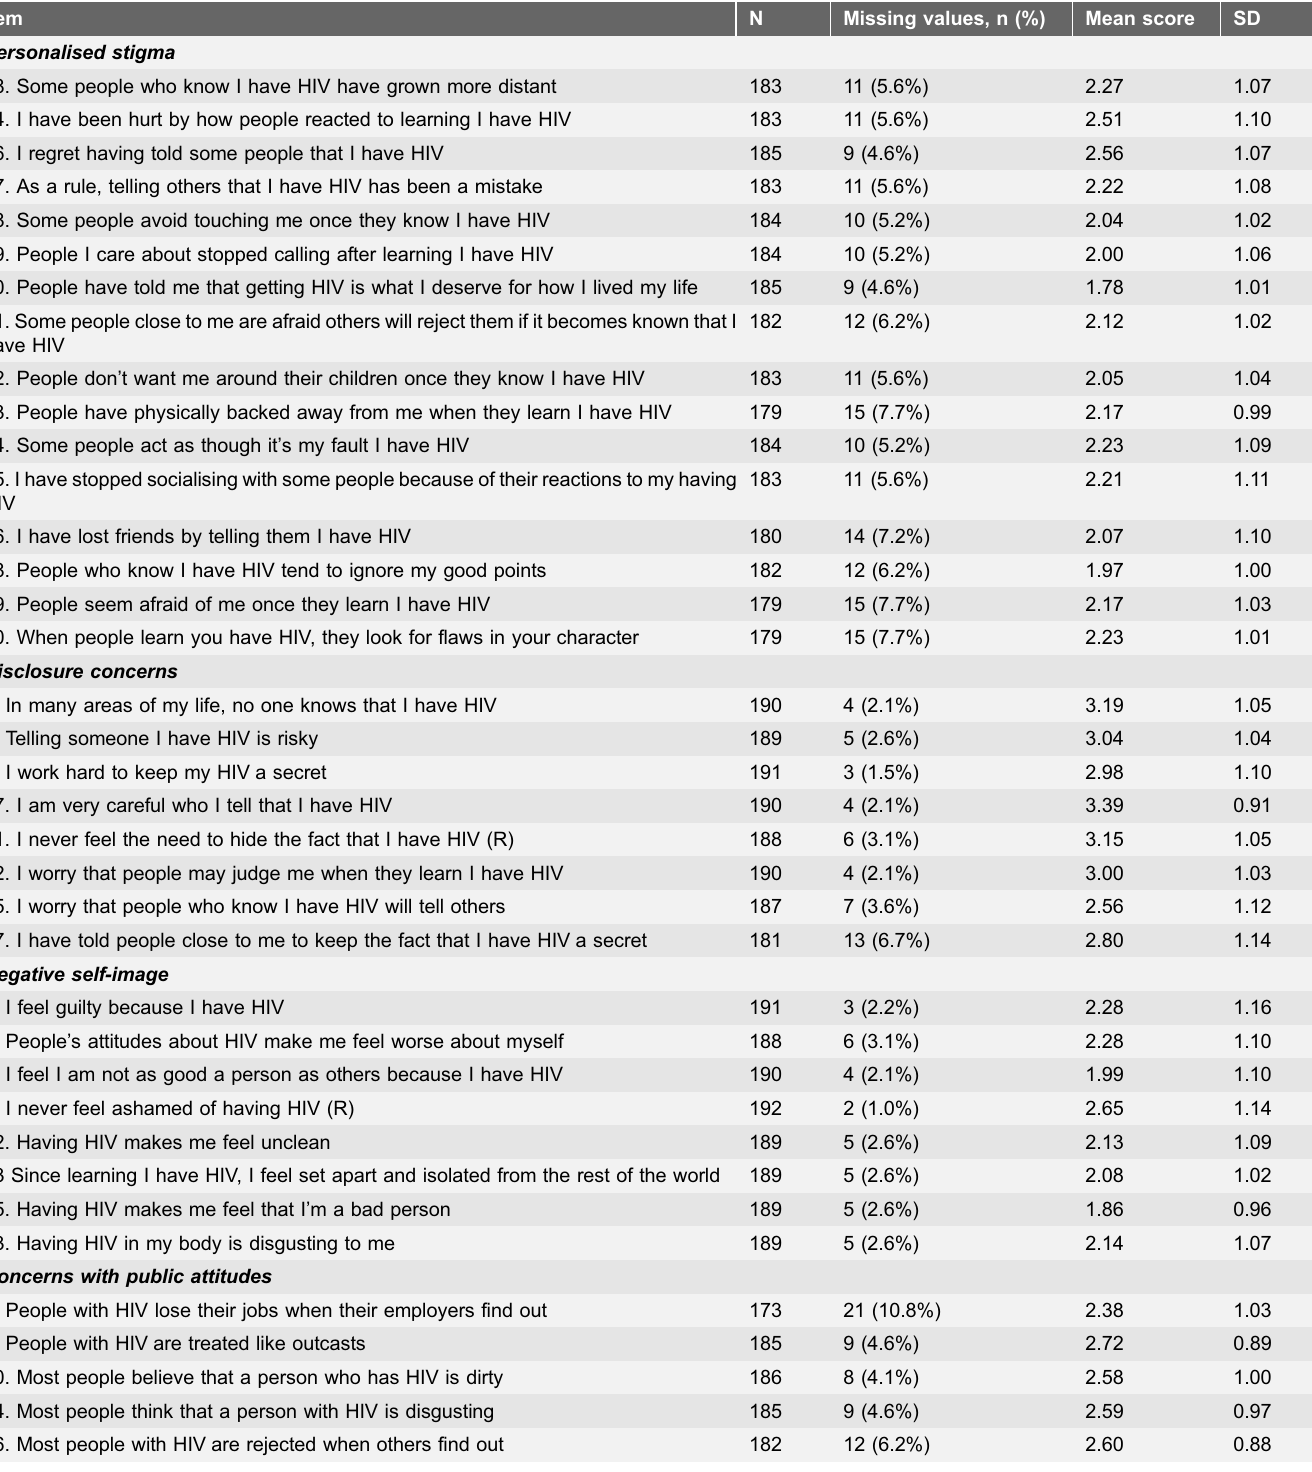
Table 3. Descriptive statistics for all 39 items in the Swedish version of the HIV stigma scale. Item N Missing values, n (%) Mean score SD Personalised